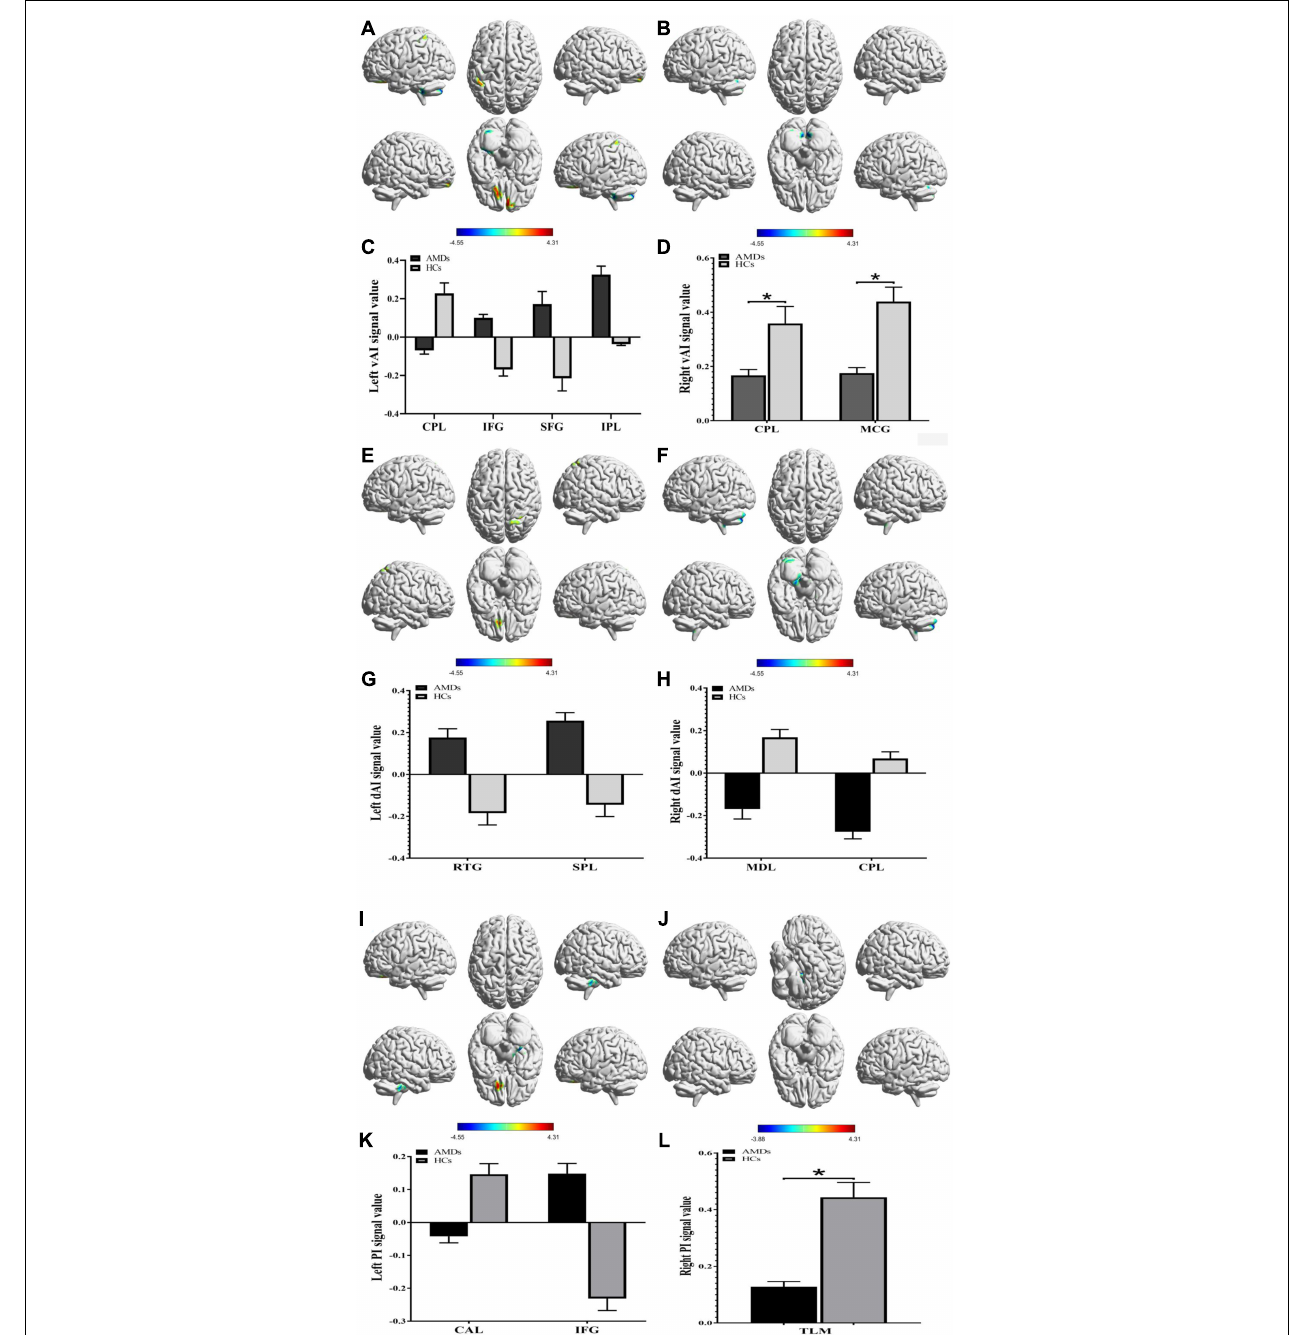
FIGURE 3 | Functional connectivity group differences in insular subregions within different cerebral areas are shown (A–L) . (A,C) , (B,D) , (E,G) , (F,H) , (I,K) , and (J,L) show cerebral regions of altered FC in the left vAI, right vAI, left dAI, right dAI, left PI, and right PI, respectively. * P < 0.01. AMDs, age-related macular degeneration group; HCs, healthy controls; vAI, ventral anterior insula; dAI, dorsal anterior insula; PI, posterior insula; CPL, cerebellum posterior lobe; IFG, inferior frontal gyrus; SFG, superior frontal gyrus; IPL, inferior parietal lobule; MCG, middle cingulate gyrus; RTG, rectal gyrus; SPL, superior parietal lobule; MDL, medulla; CAL, cerebellum anterior lobe; TLM,